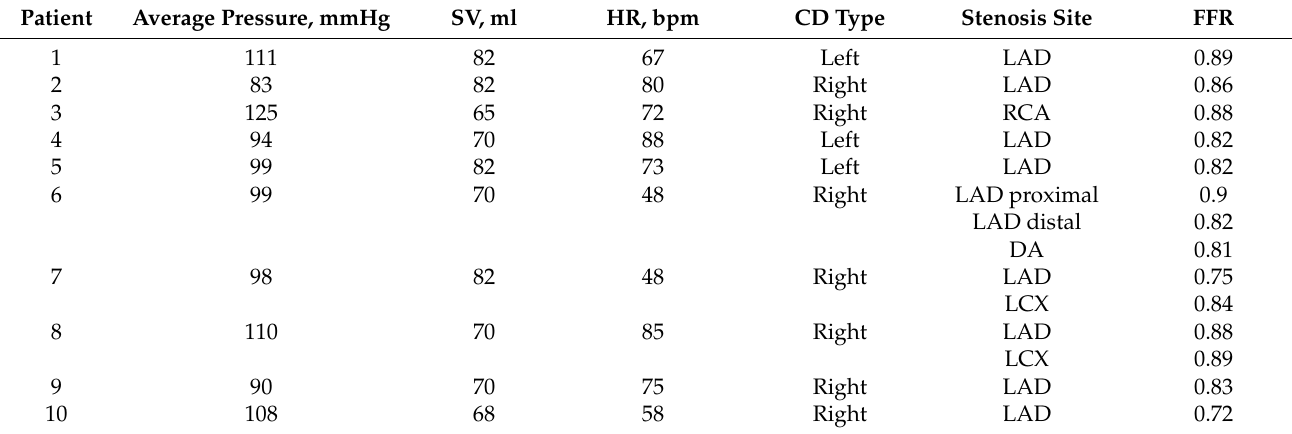
Table 1. Clinical data for patients. Stroke volume values are estimated based on patient’s BMI. CD—coronary dominance. Patient Average Pressure, mmHg